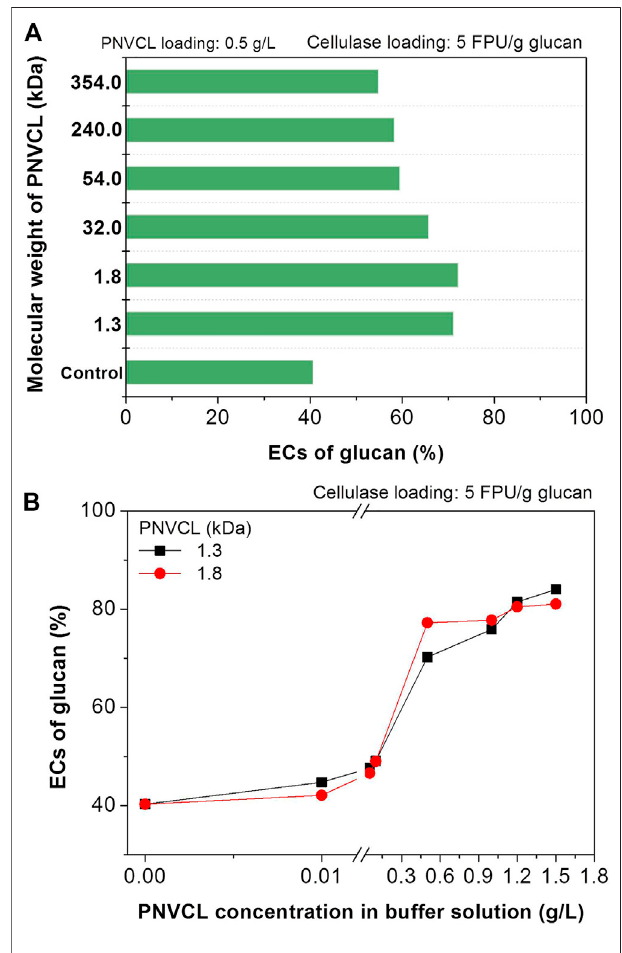
FIGURE 4 | Effects of (A) PNVCL molecular weight and (B) PNVCL loading on the ECs of glucan in PSA-Ba substrate. The pH value of acetate buffer solution and β -glucosidase loading are fi ve and 7.5 CBU/g glucan. The control experiments shown in Fig.3, Figure 4A and Figure 5 denote the enzymatic hydrolysis of PSA-Ba substrate without